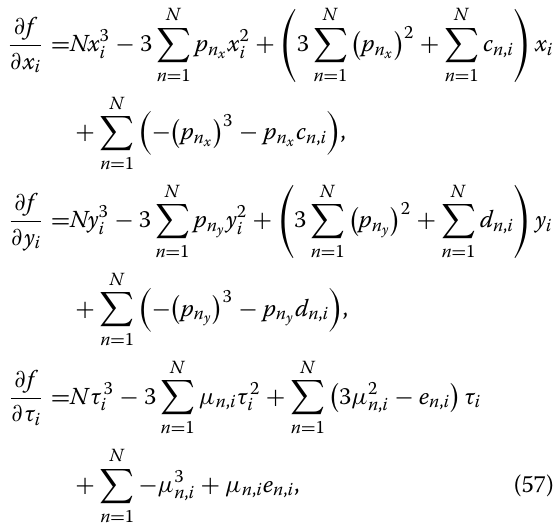
Algorithm 2 for different initial values of τ 1 , ..., τ I and